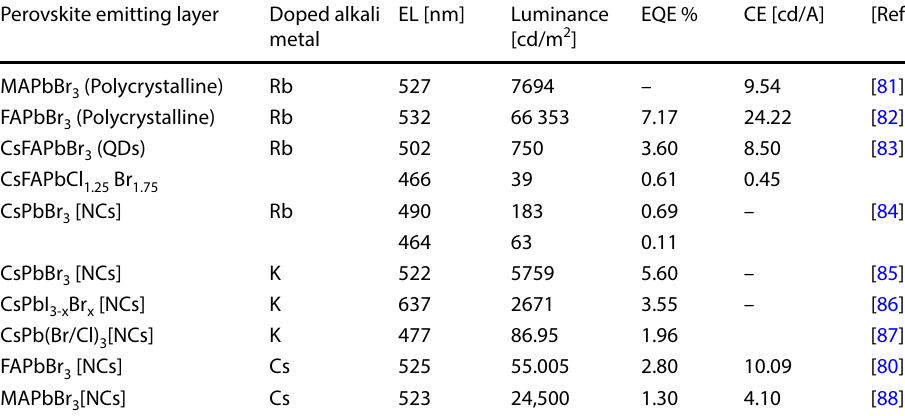
Perovskite emitting